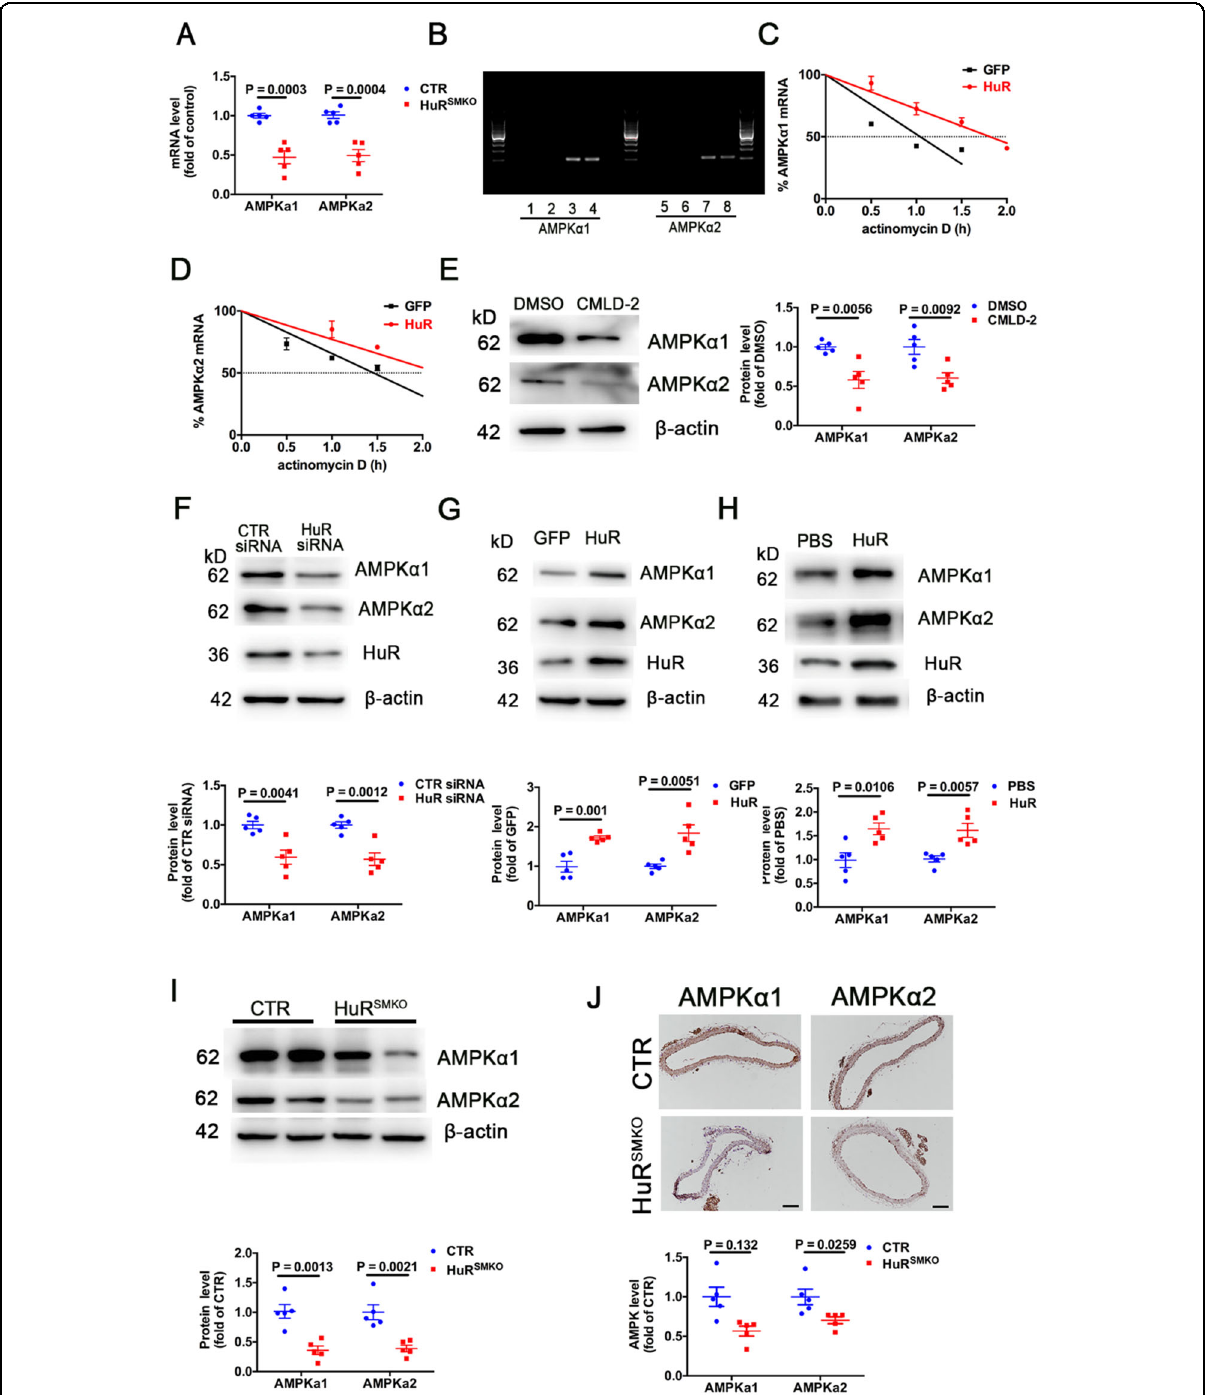
Fig. 5 AMPK α 1 and AMPK α 2 are the target genes of HuR. A Quantitative RT-PCR analysis of aortic mRNA levels of AMPK α 1, AMPK α 2 from CTR and HuR SMKO mice ( n = 5). B RNA immunoprecipitation with anti-HuR or control IgG antibody. Lanes 1, 5, no template PCR control; lanes 2, 6, IgG RNA immunoprecipitation; lanes 3, 7, anti-HuR RNA immunoprecipitation; lanes 4, 8, 10% input. C , D VSMCs were infected with adenovirus-expressing GFP (green fl uorescent protein) or HuR and then treated with actinomycin D (5 μ g/ml). Quanti fi ed RT-PCR analysis of percentage mRNA levels of AMPK α 1 ( C ) and AMPK α 2 ( D ) ( n = 5) in VSMCs. E Western blot analysis of AMPK α 1 and AMPK α 2 in VSMCs treated with DMSO or 30 μ M CMLD-2 for 24 h ( n = 5). F Western blot analysis of AMPK α 1 and AMPK α 2 in VSMCs transfected with CTR siRNA or HuR siRNA for 48 h ( n = 5). Western blot analysis of AMPK α 1 and AMPK α 2 in VSMCs, G infected with ad-GFP or HuR ( n = 5), and H treated with PBS or 0.5 μ g/ μ l recombinant HuR protein for 48 h ( n = 5). I Western blot analysis of AMPK α 1 and AMPK α 2 in aortas from CTR and HuR SMKO mice ( n = 5). J Immunohistochemical staining of AMPK α 1 and AMPK α 2 in aortas from CTR and HuR SMKO mice ( n = 5). Scale bar = 100 μ m. Of fi cial journal of the Cell Death Differentiation